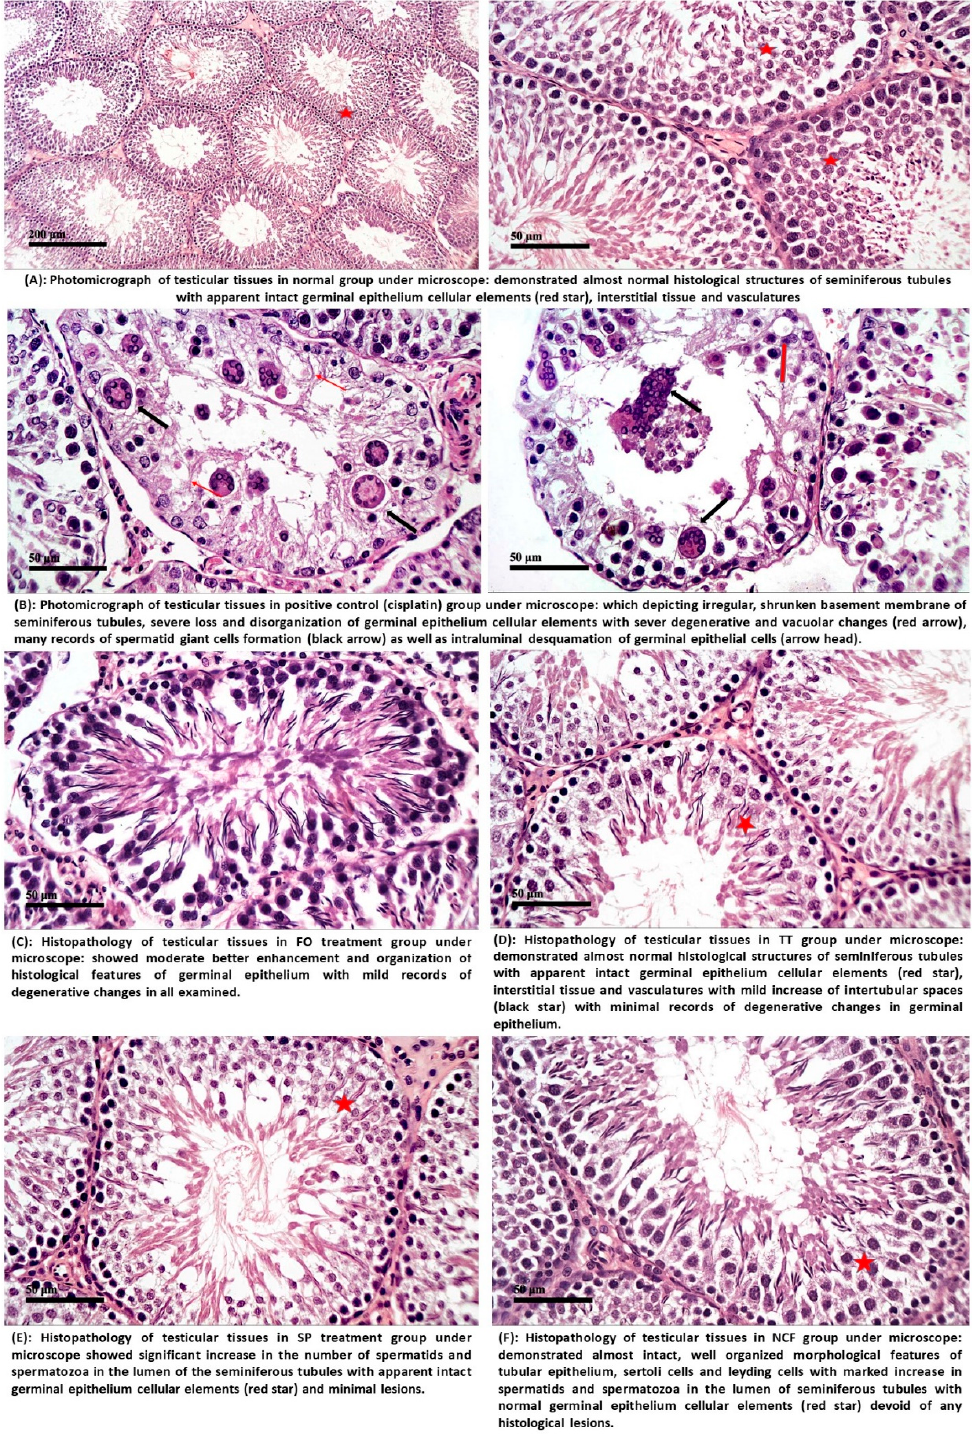
Figure 10. Histopathological estimation for; ( A ): NC, ( B ): CP, ( C ): FO, ( D ): TT; ( E ): SP; ( F ): NCF .